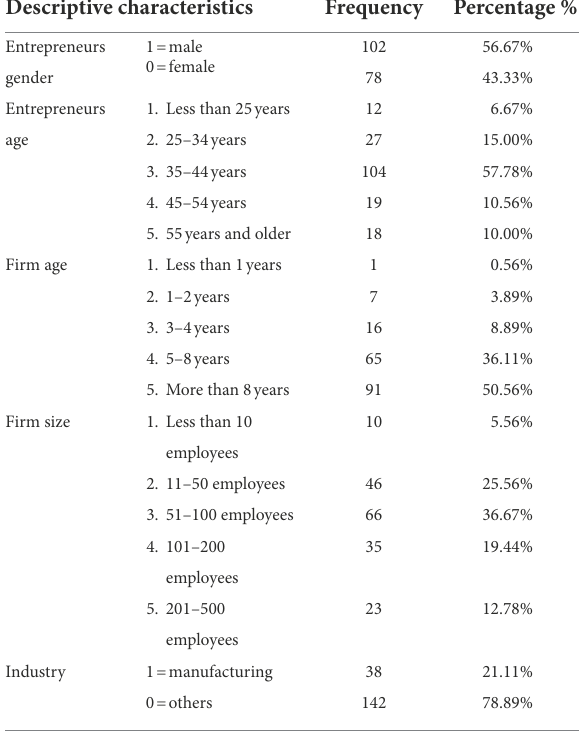
TABLE 1 Sample descriptions ( N =